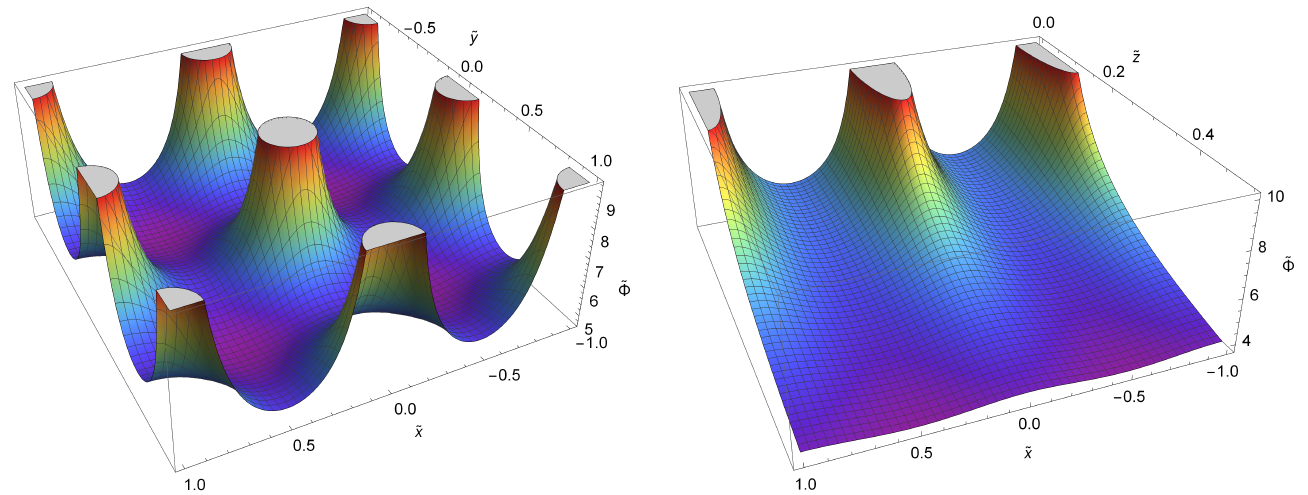
(cid:2) − (cid:3) − 1 G N m / ( c 2 al ) Figure 3. ˜ Φ = (cid:98) Φ for ˜ λ eff = 1 for the sections z = 0 (left panel) and y = 0 (right panel).